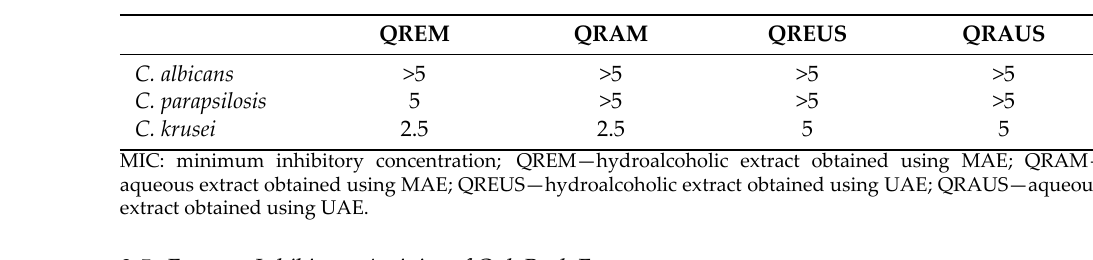
Table 4. Antifungal activity (MIC in mg/mL) of the oak bark extracts.